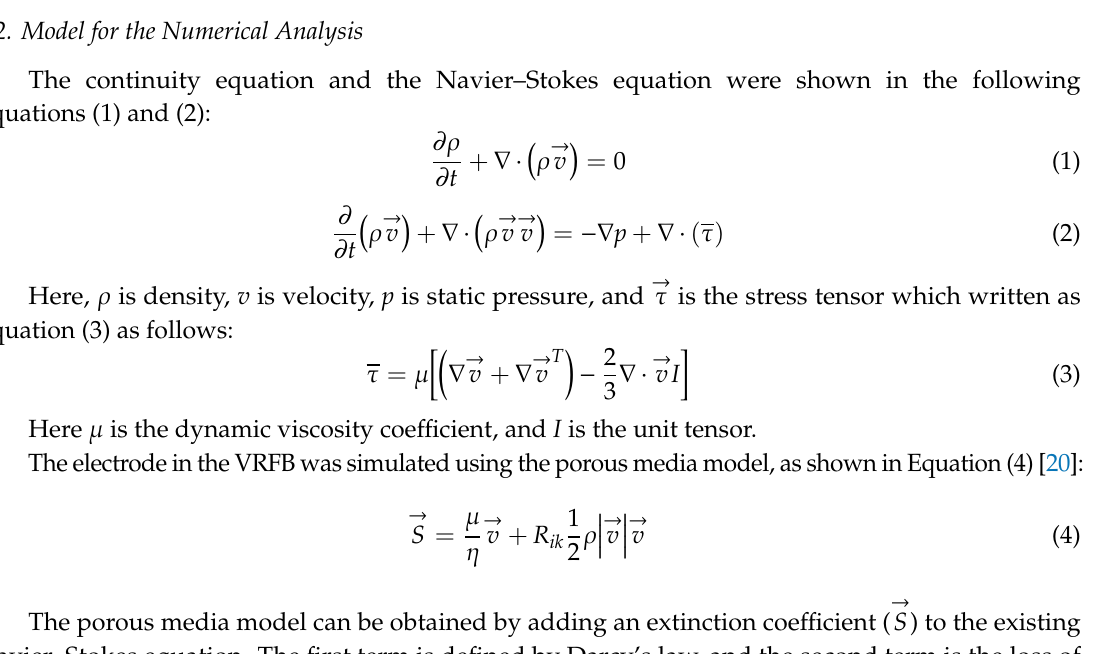
Figure 4. Grid system according to average mesh volume (at size 0.1 mm 3